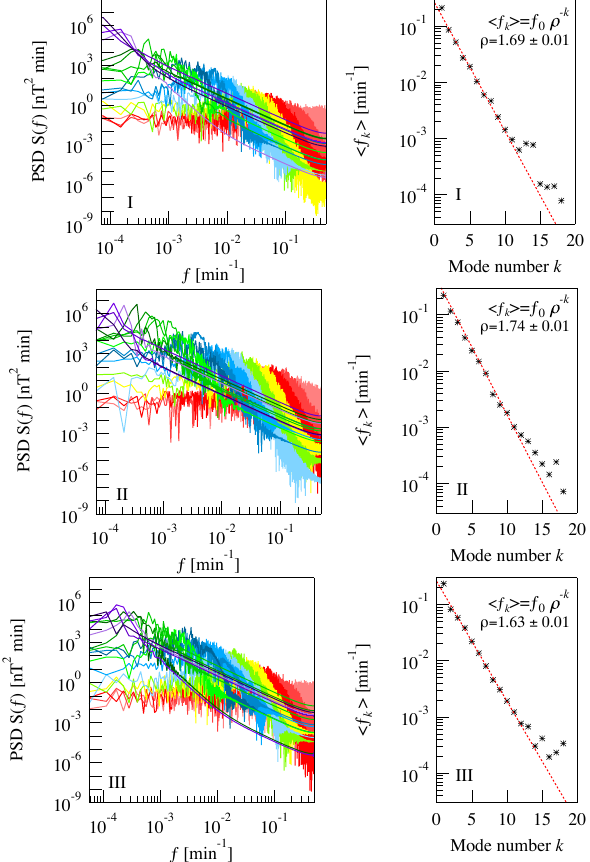
Fig. 3. On the left: Fourier spectrum of all IMFs (from 1 to 19) obtained by EMD for the three subintervals into which period B has been divided (I: 1–9 July 2000; II: 10–18 July 2000; III: 19– 31 July 2000, (from top to bottom). On the right: representation of the mean frequency vs. index k in a log-linear view.